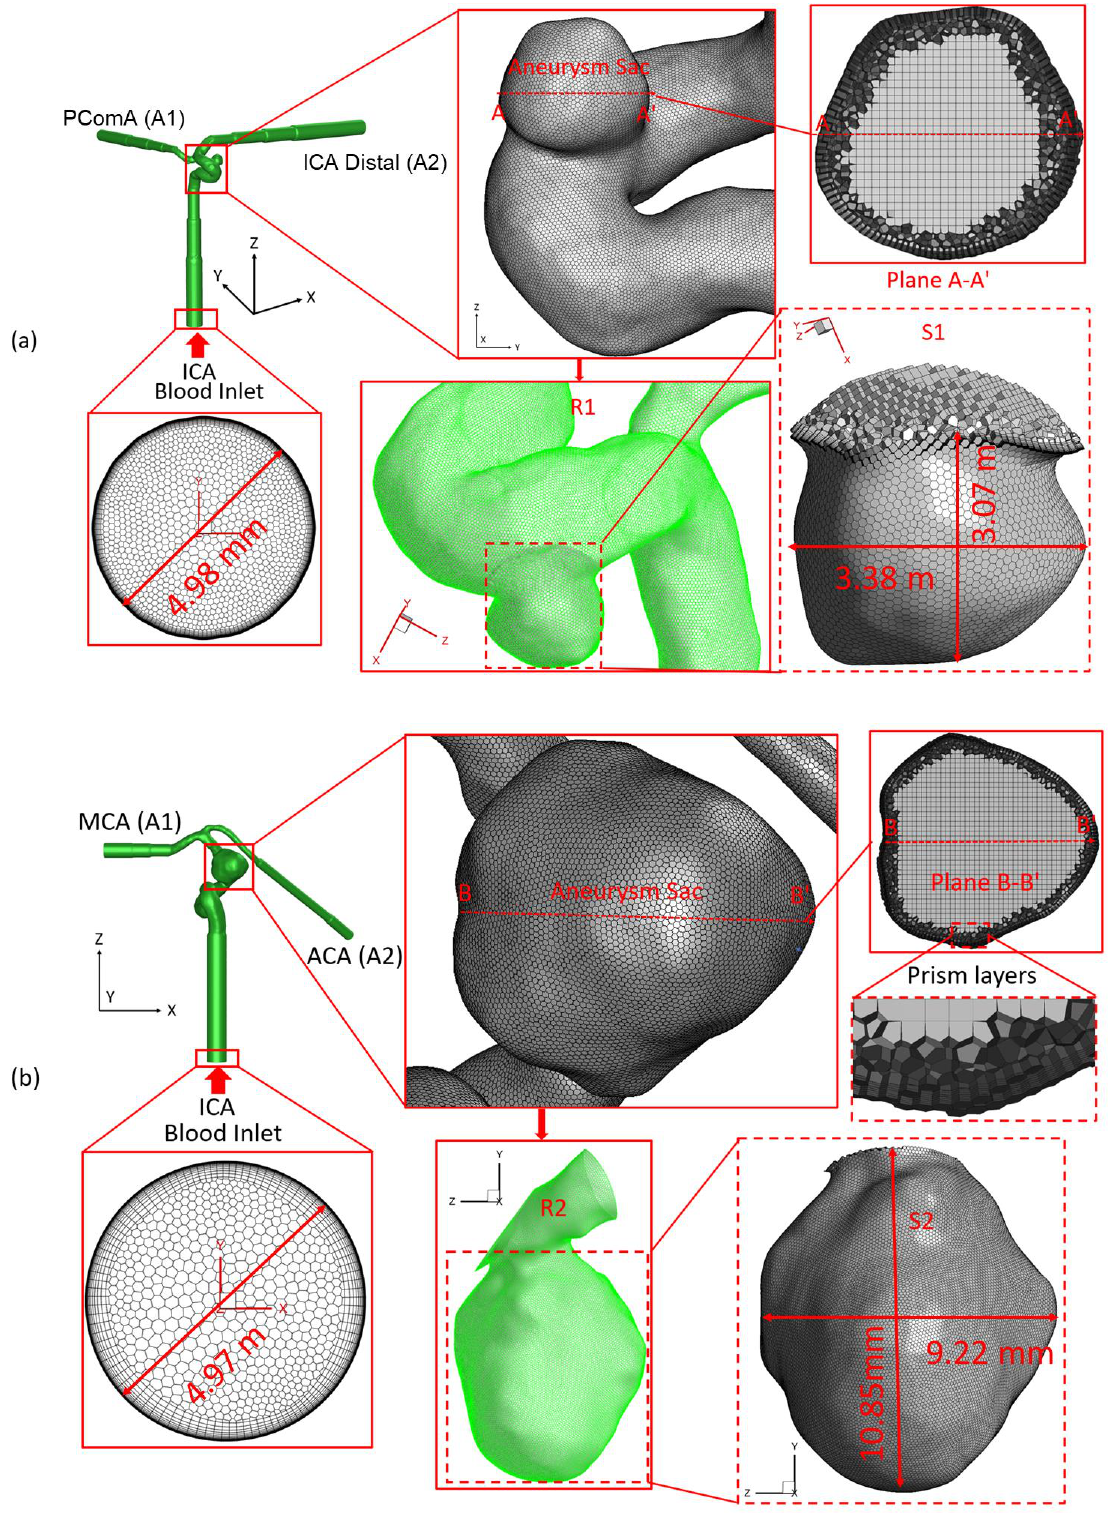
Figure 1. Schematic of the computational domain with hybrid mesh details in ICASA